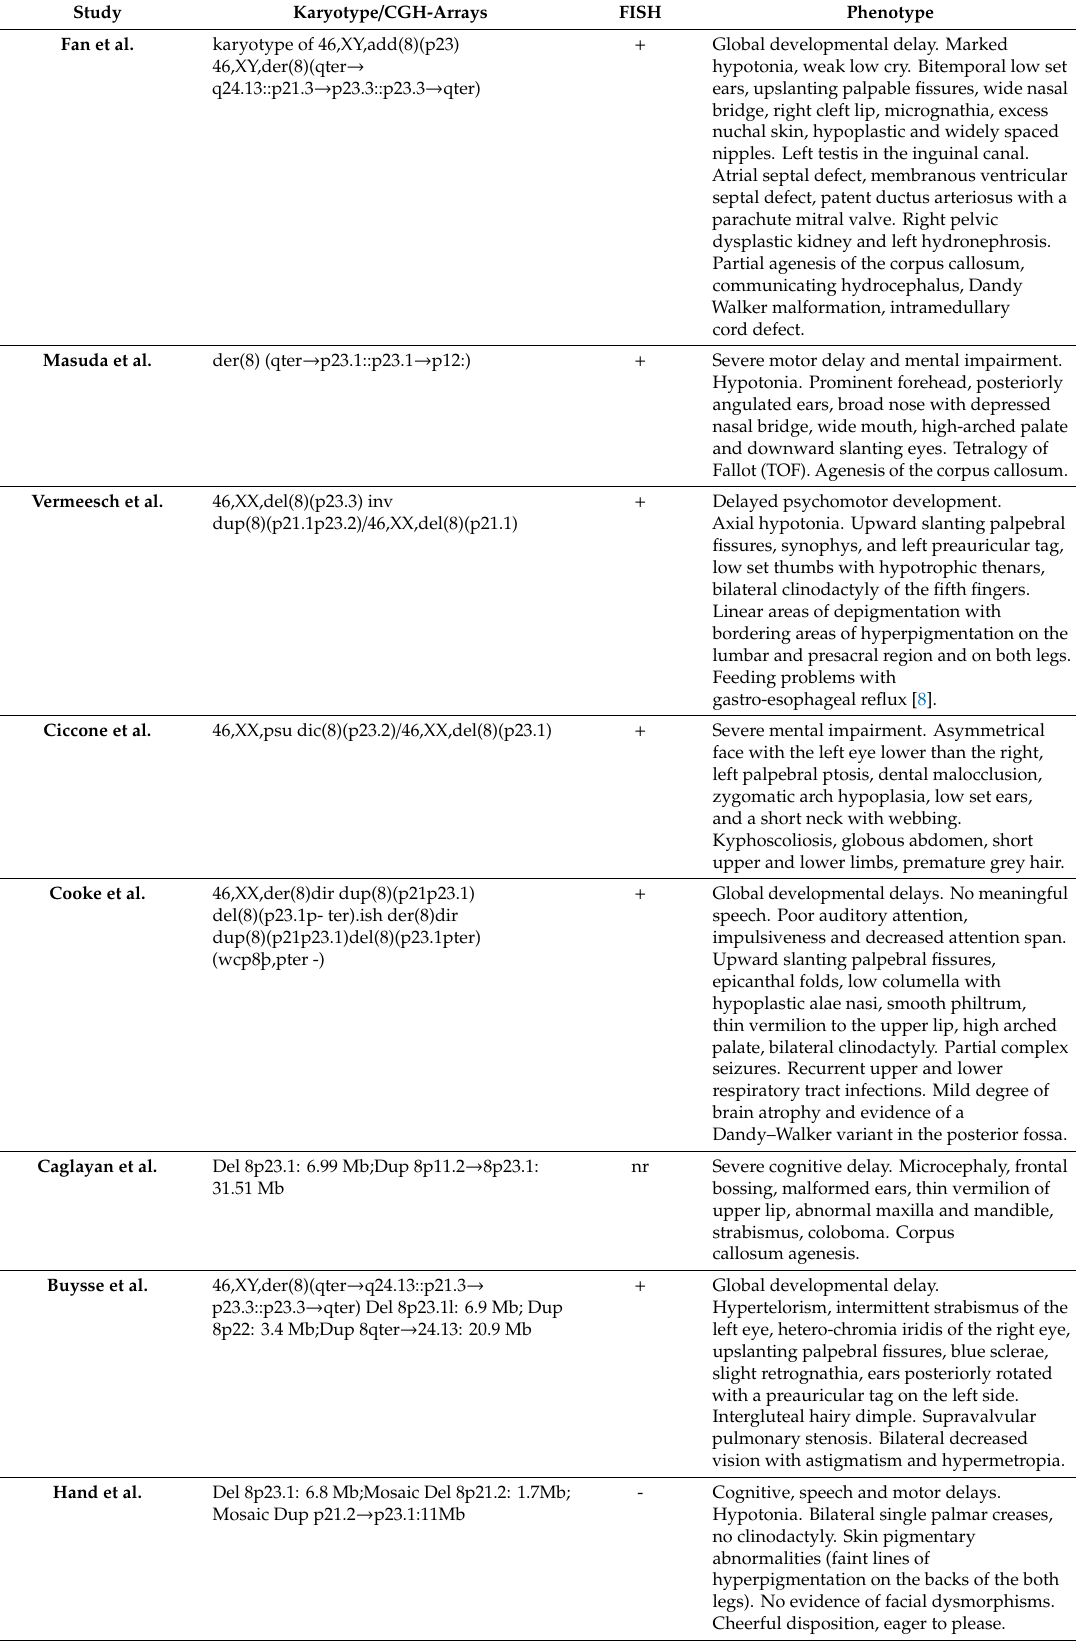
Table 1. Karyotype / CGH-arrays, FISH analysis results and phenotypes reported in previous studies and in our patient. + , analysis performed; - analysis not performed; nr, data not reported. Study Karyotype / CGH-Arrays FISH